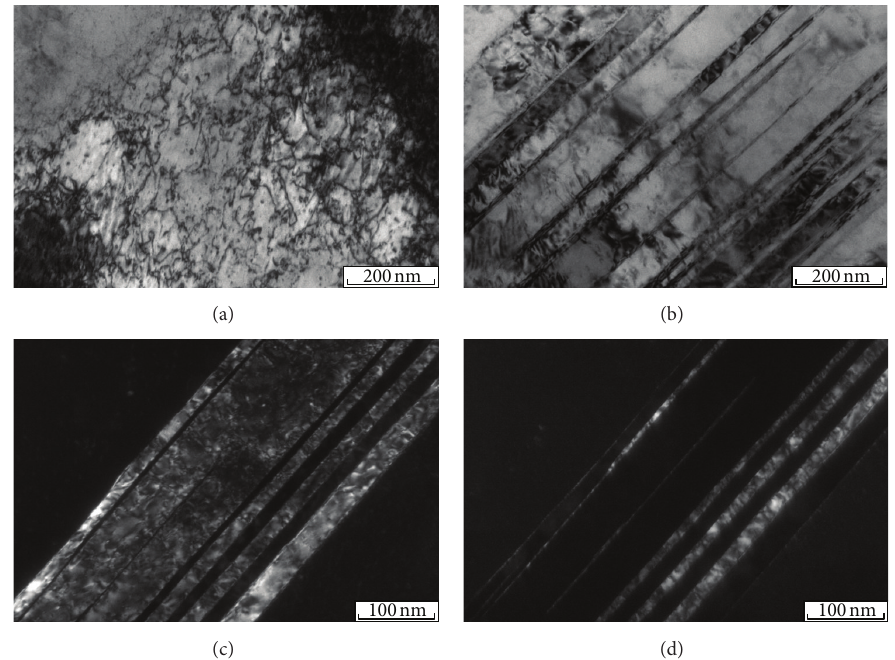
Figure 7: Dislocation structure (a) and twins of deformation origin (b–d) in a copper plate at a distance of 50 𝜇 m from the intermediate layer. (b) bright-field and (c, d) dark-field transmission electron micrographs of the same section.